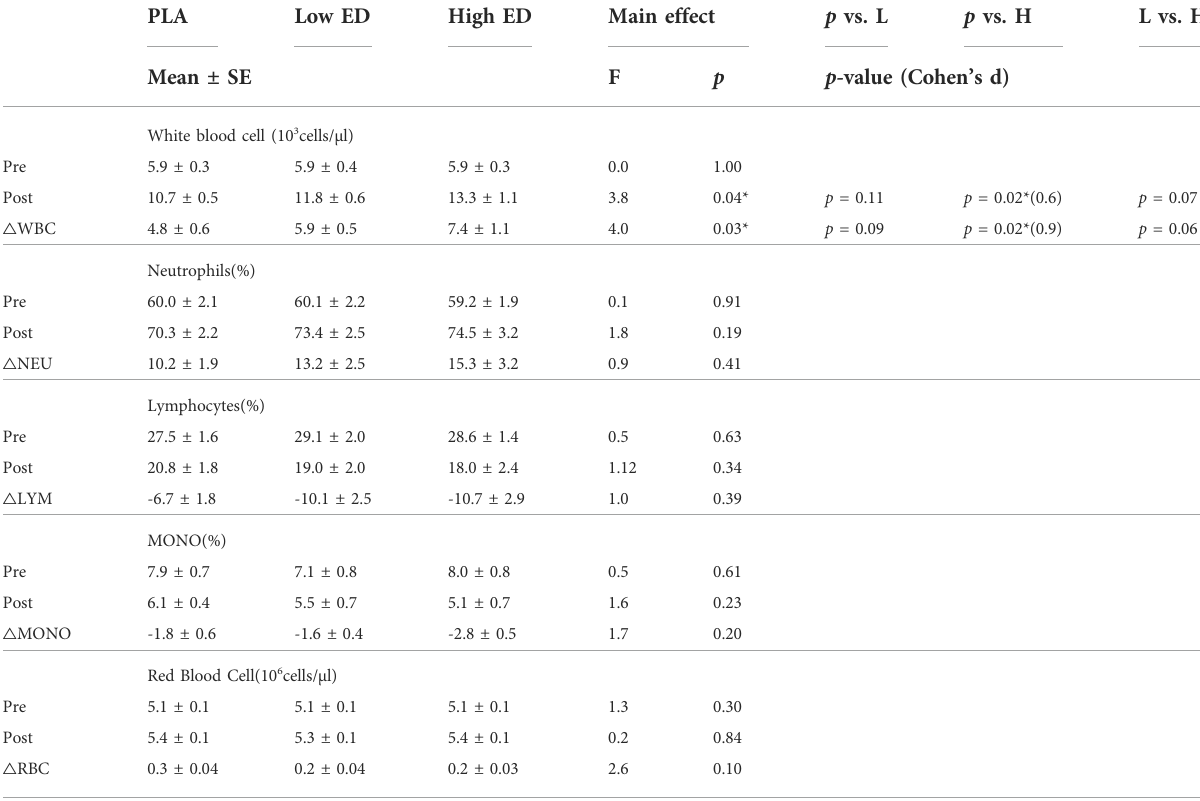
TABLE 1 Hematological parameters with placebo (PLA), low-dosage caffeinated energy drink (Low ED) group and high-dosage caffeinated energy drink (High ED) group before and after participation in a sprint triathlon. *Signi fi cant difference at p < 0.05. PLA Low ED High ED Main effect p vs. L p vs. H L vs.